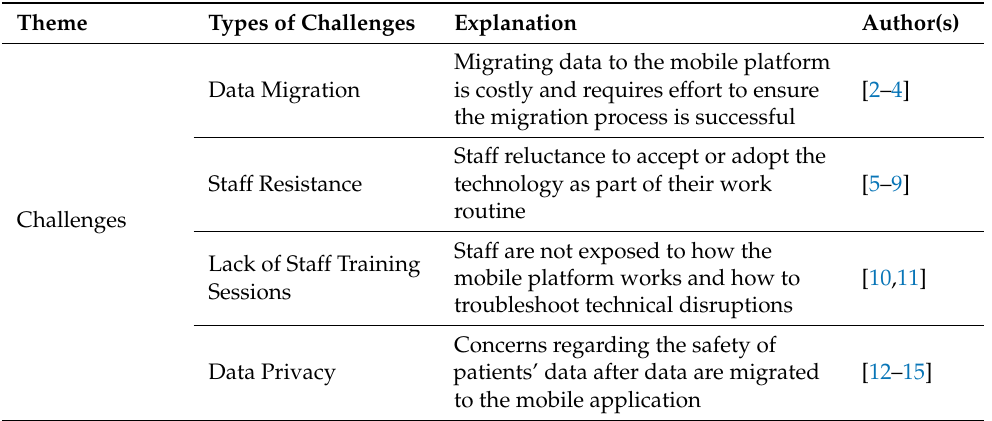
Table 1. Challenges of Trust Elements in the MHRM management